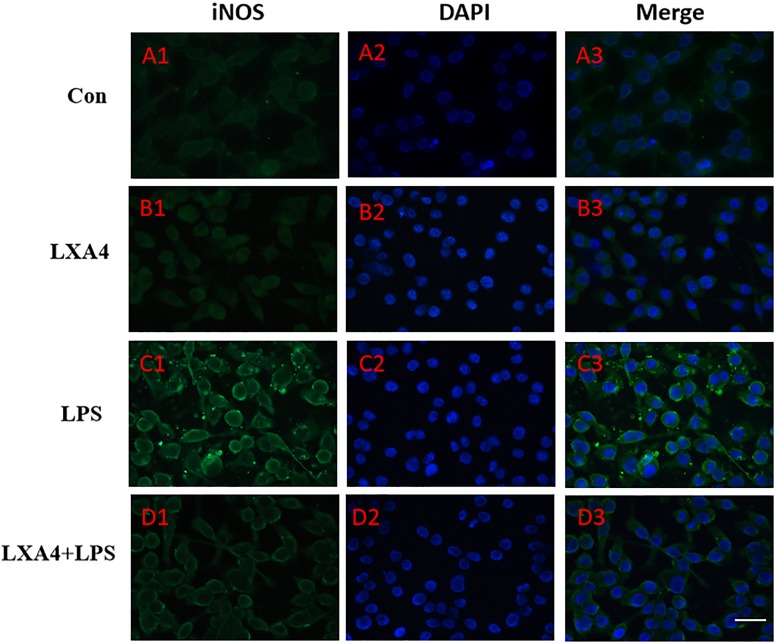
Immunofluorescence images showing the BV2 microglia after LPS stimulates which were labeled with iNOS antibody, with LXA4, the expression of iNOS is decreased. Green fluorescence indicated iNOS positive cells, while blue fluorescence indicated DAPI-labeled nuclei. Scale bar: 20 μm.